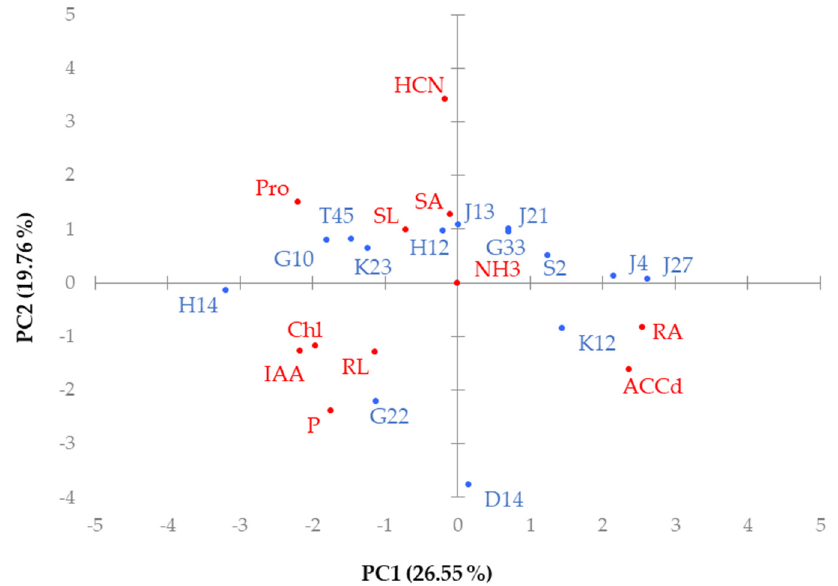
Figure 7. Biplot obtained from the principal component analysis (PCA) on the dataset of in vitro and in planta results (loadings, in red) recorded for actinomycete strains (scores, in blue) without salt stress. In the figure: ACCd, 1-aminocyclopropane-1-carboxylate deaminase activity; Chl, total chlorophyll; SL, length of shoots; RL, length of roots; RA, ash-free dry weight of roots; SA, ash-free dry weight of shoots; Pro, proline; P, phosphate solubilization; IAA, indole-3-acetic acid.